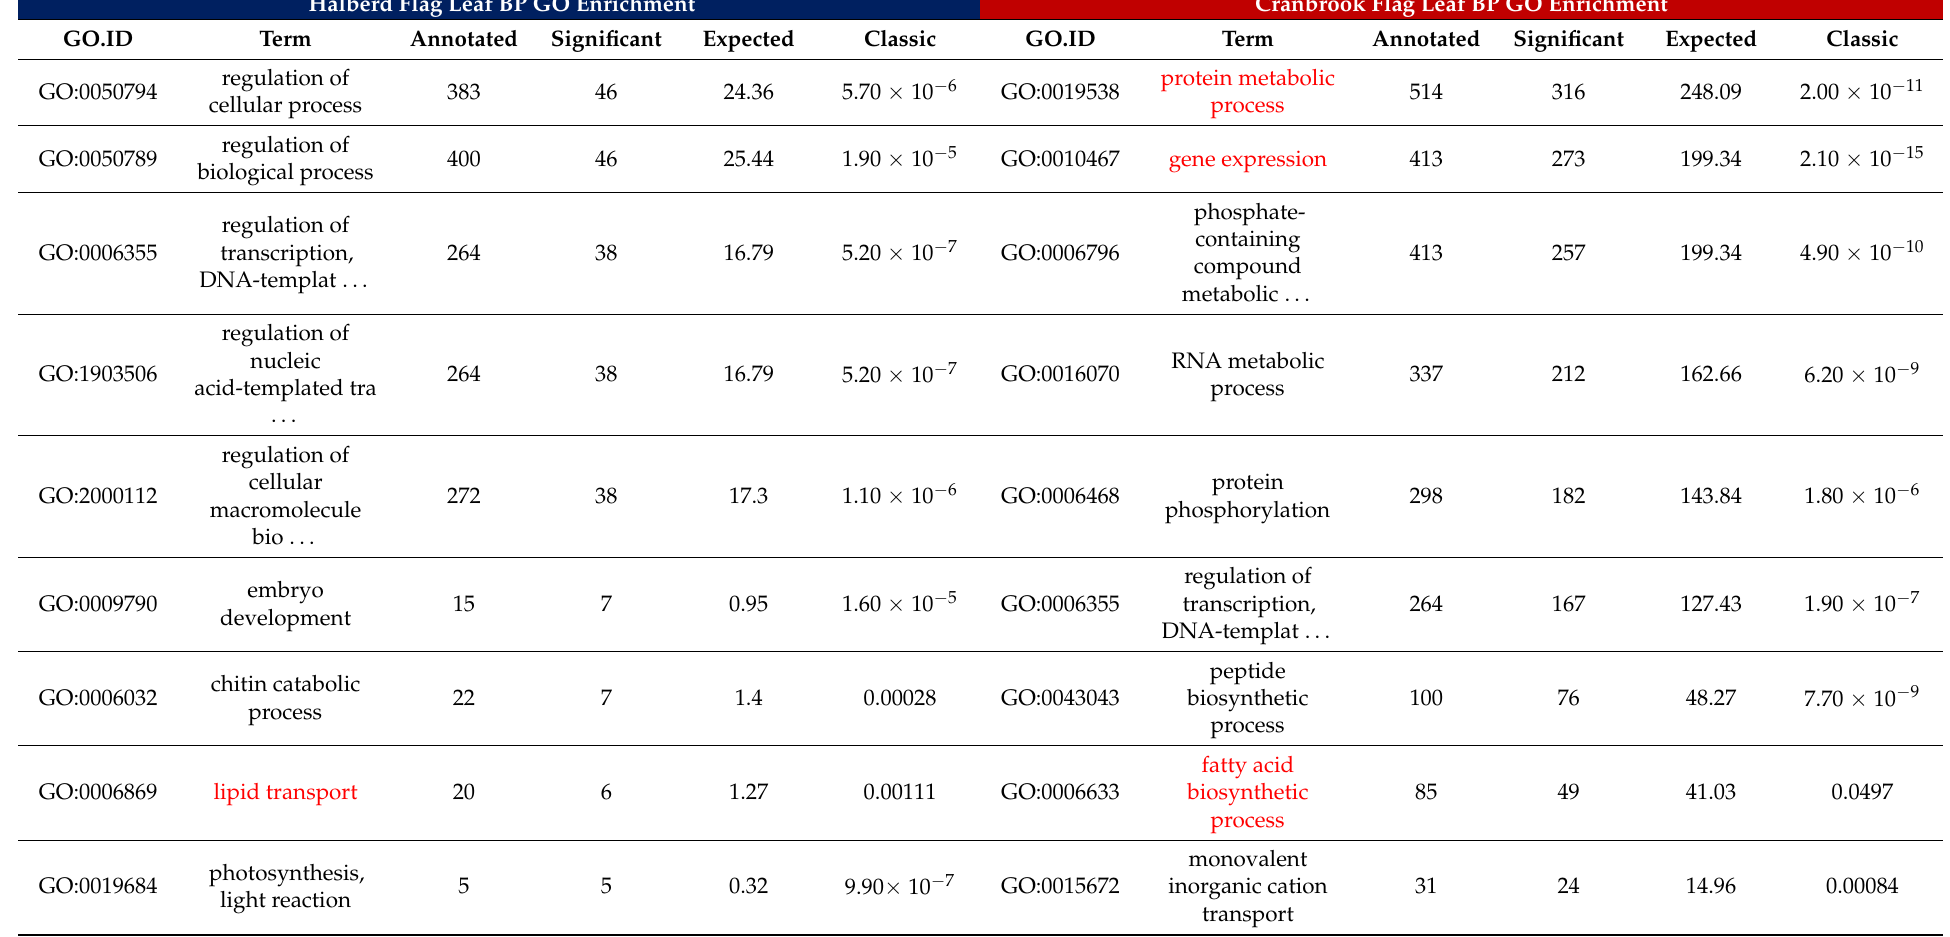
Table 1. GO enrichment analysis for biological processes (BP) using Halberd and Cranbrook flag leaf DEG. Halberd Flag Leaf BP GO Enrichment Cranbrook Flag Leaf BP GO